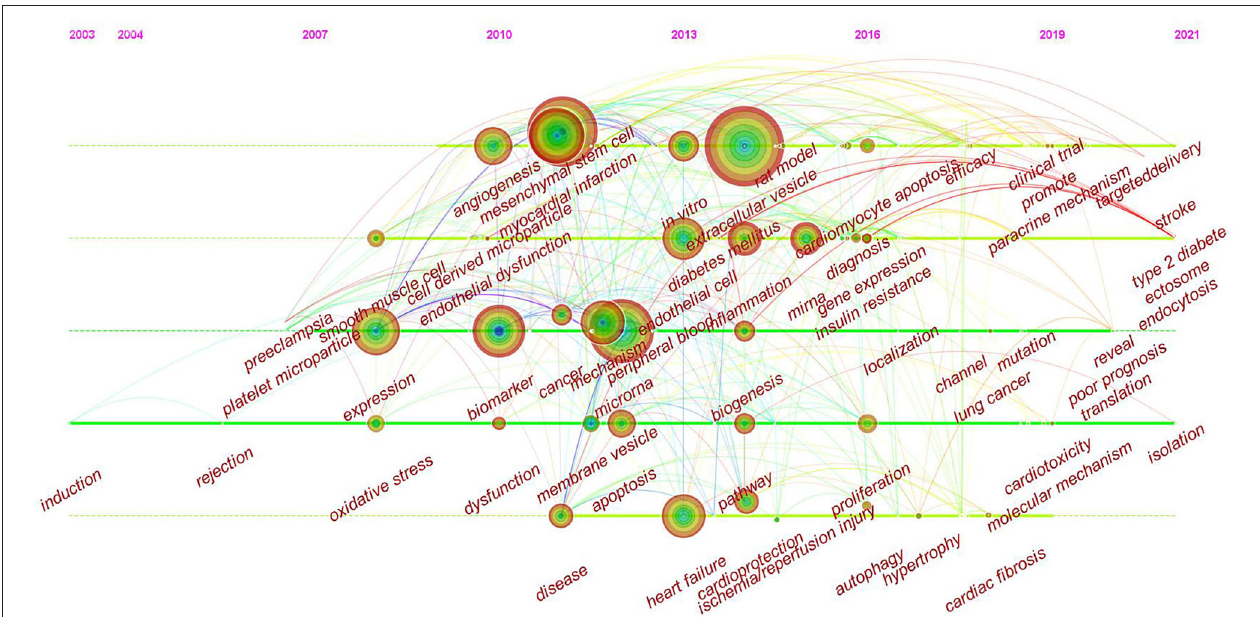
FIGURE 10 | CiteSpace visualization map of timeline viewer related to exosomes in